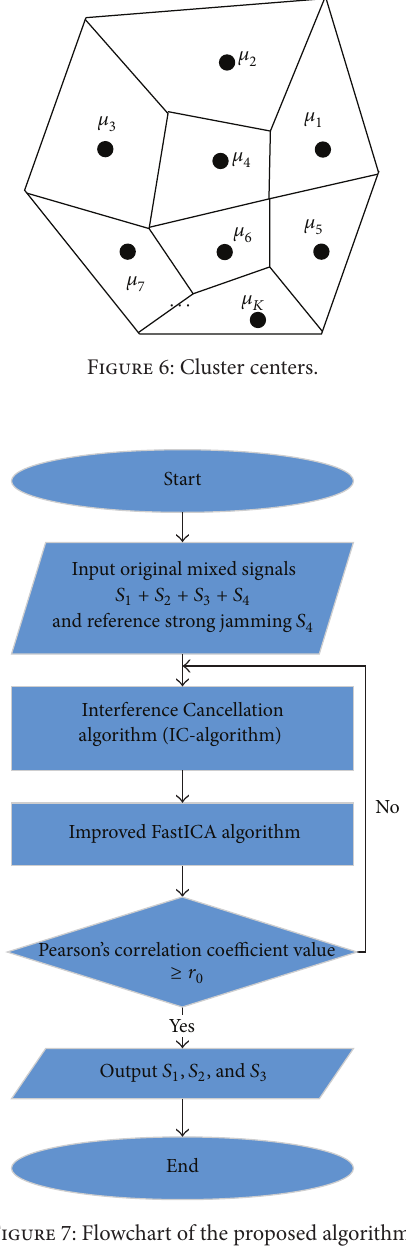
Figure 7: Flowchart of the proposed